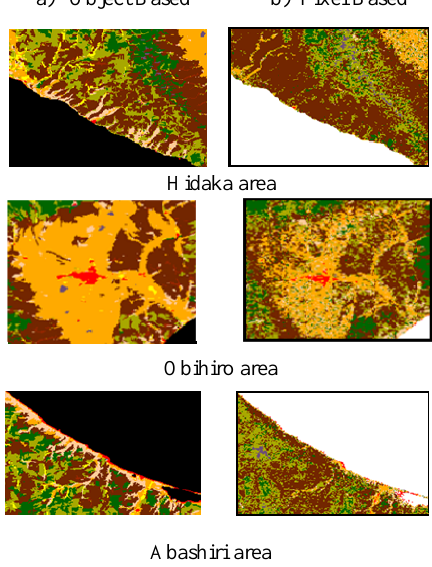
Figure 7. Comparison of object based classification and pixel based